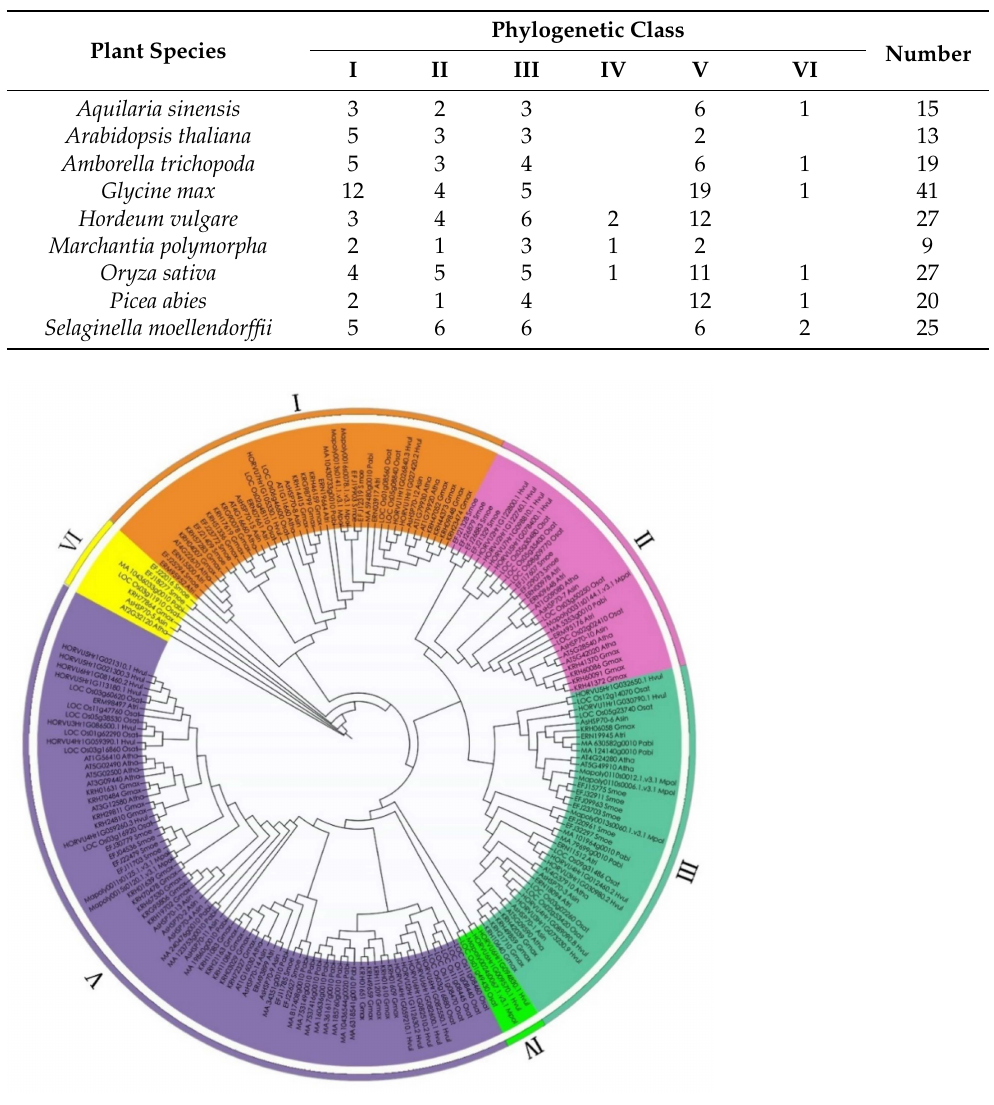
Figure 3. Phylogenetic relationship of HSP70 in A. sin ( Aquilaria sinensis ), A. tha ( Arabidopsis thaliana ), A. tri ( Amborella trichopoda ), G. max ( Glycine max ), H. vul ( Hordeum vulgare ), M. pol ( Marchantia polymorpha